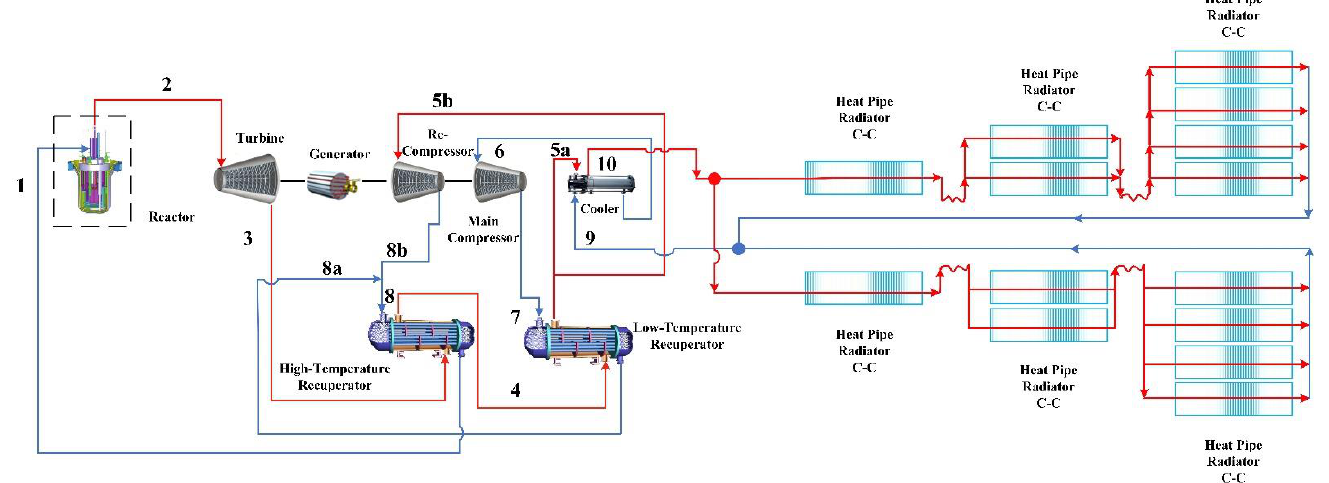
Figure 3. Structure diagram for the proposed S-(N 2 O-He) cycle.